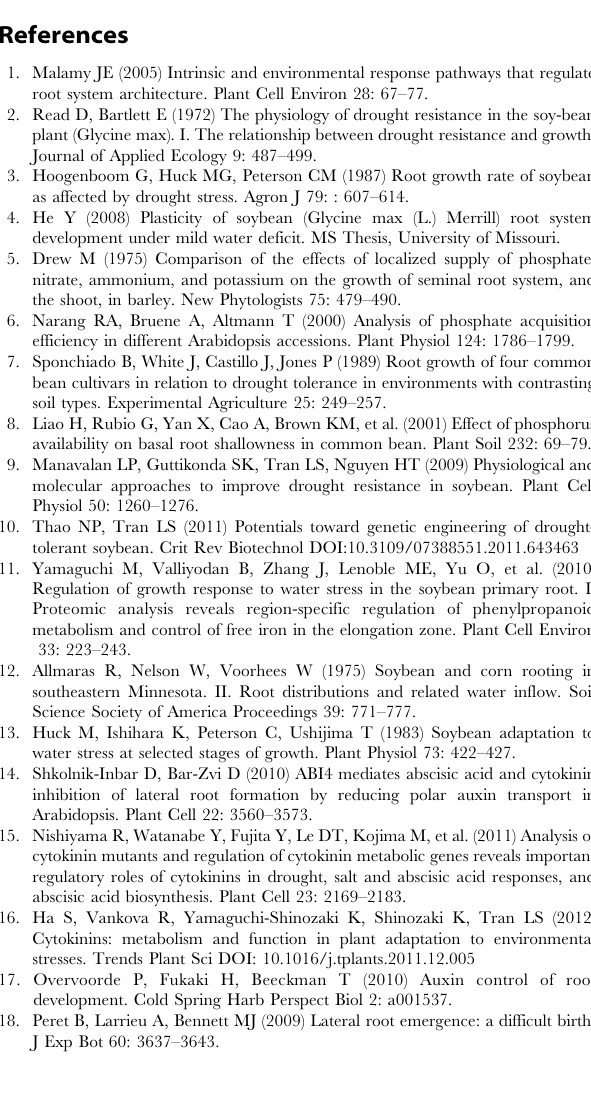
Figure S1 Phylogenetic tree of soybean NAC proteins according to Le et al. (2011). Tree was drawn using Mega 5.1 software (Tamura et al. 2011) with a bootstrap of 500 replicates. GmNAC20 (Hao et al. 2011) and GmNAC003 and GmNAC004 (this paper) were noted on right side, adjacent to the names assigned by Le et al. (2011).